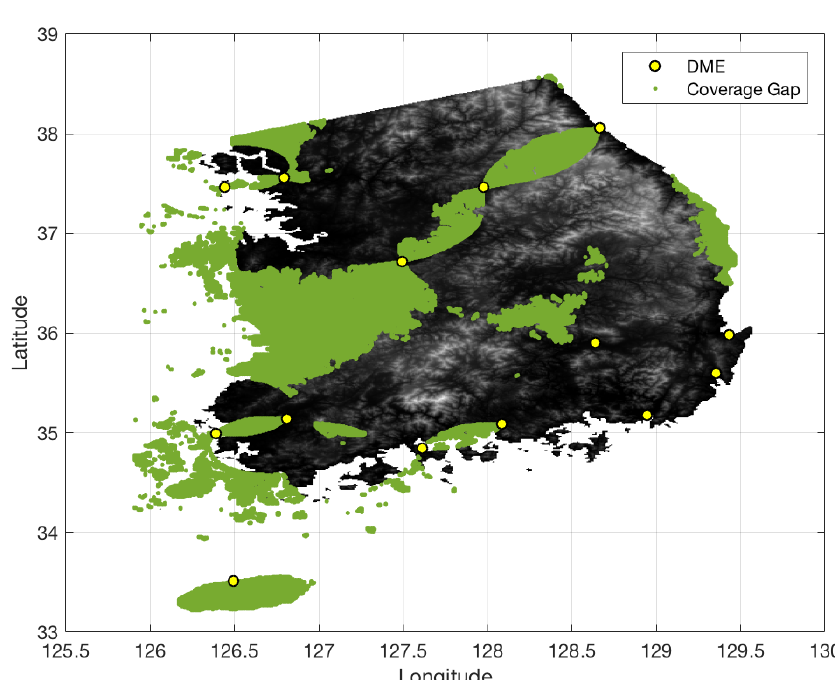
Figure 14. DME/DME coverage of 1.0 nm horizontal positioning accuracy in South Korea with legacy DME performance and the current DME ground network.